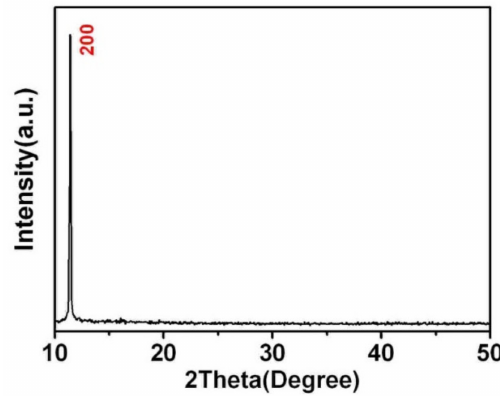
Figure 3. XRD 2 patterns of the